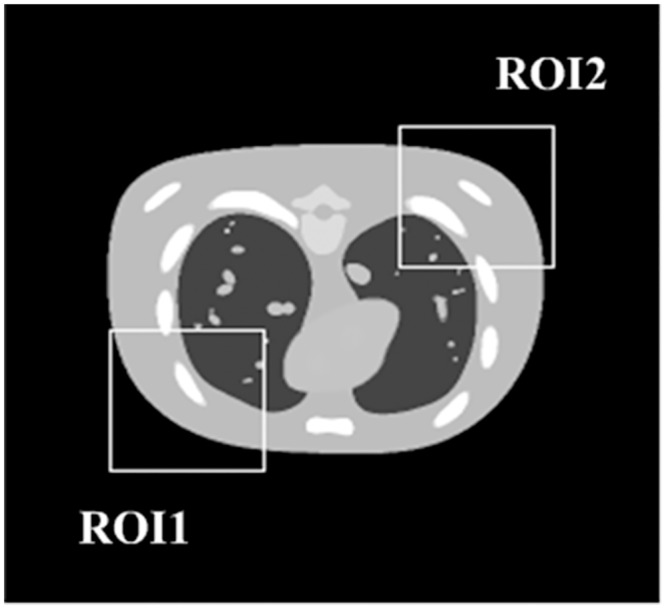
A typical phase of the NCAT phantom.